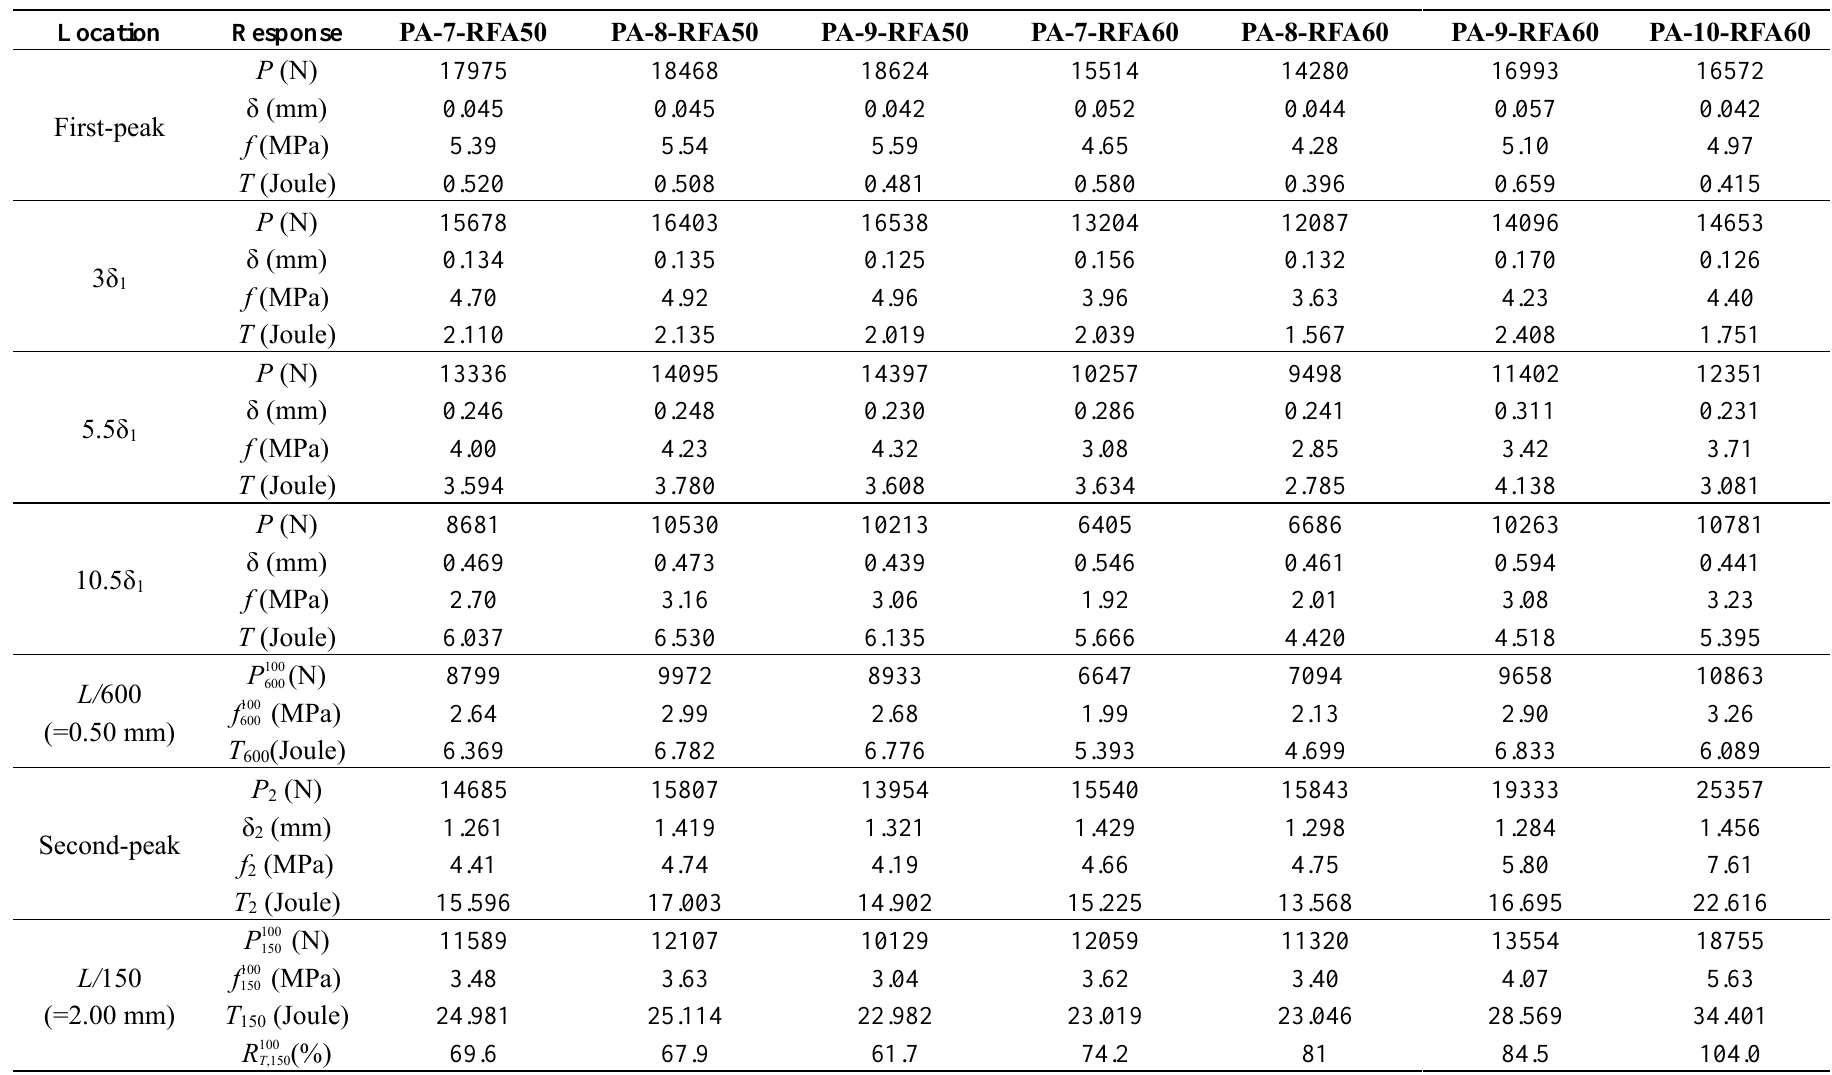
Table 5. Average value of flexural responses of